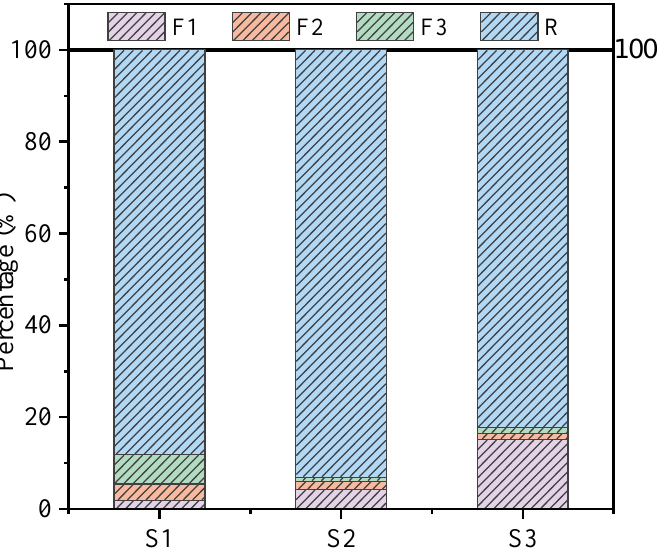
Figure 1. The percentage of each fraction of As in TT extracted by the BCR sequential extraction procedure.